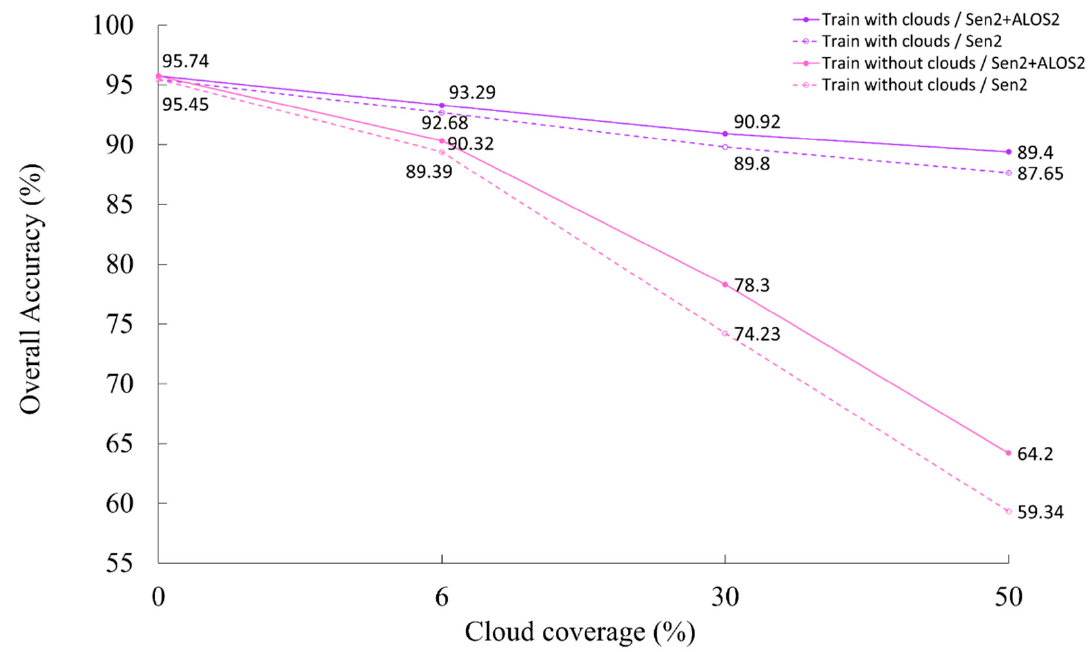
Figure 7. The overall accuracy of training with/without cloud-covered samples under different types of cloud coverage using single optical data and combined optical and SAR data.